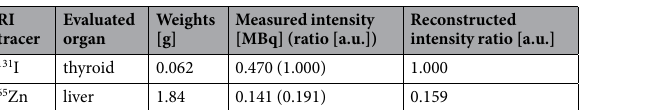
Table 2. Comparison of the intensity of the radioactive